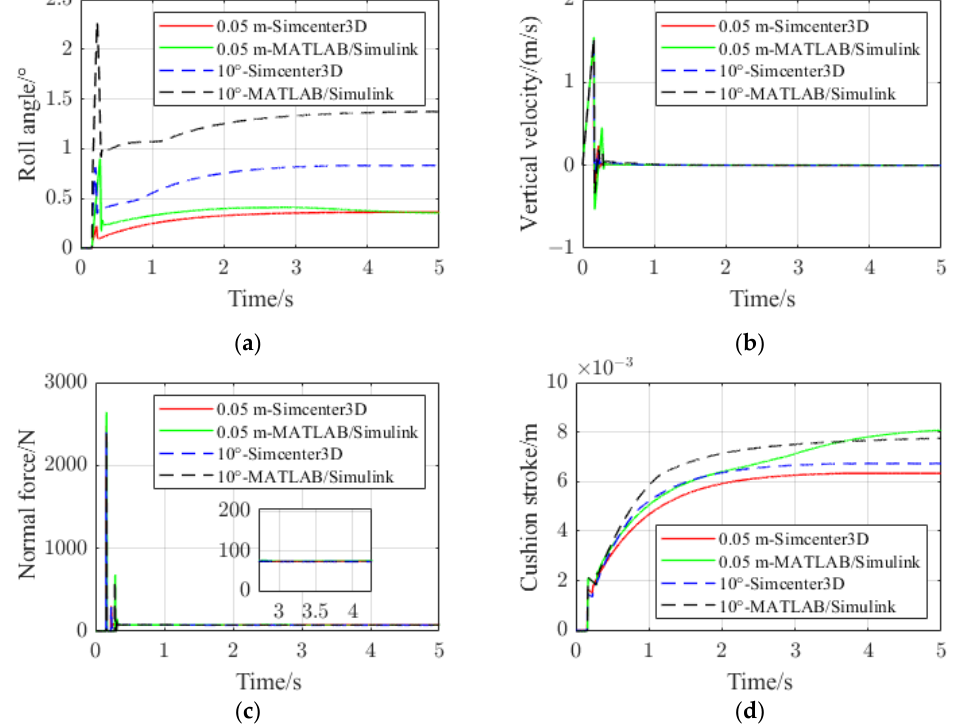
Figure 7. The drop test simulation curves in MATLAB/Simulink and Simcenter3D in landing terrains with a height difference of 0.05 m and slope angle of 10°: ( a ) represents the roll angle of the whole rotorcraft; ( b ) represents the vertical velocity of rotorcraft; ( c ) represents the normal force acting on the footpad of landing leg No. 1; ( d ) represents the cushion stroke of the shock absorber on landing leg No. 1.